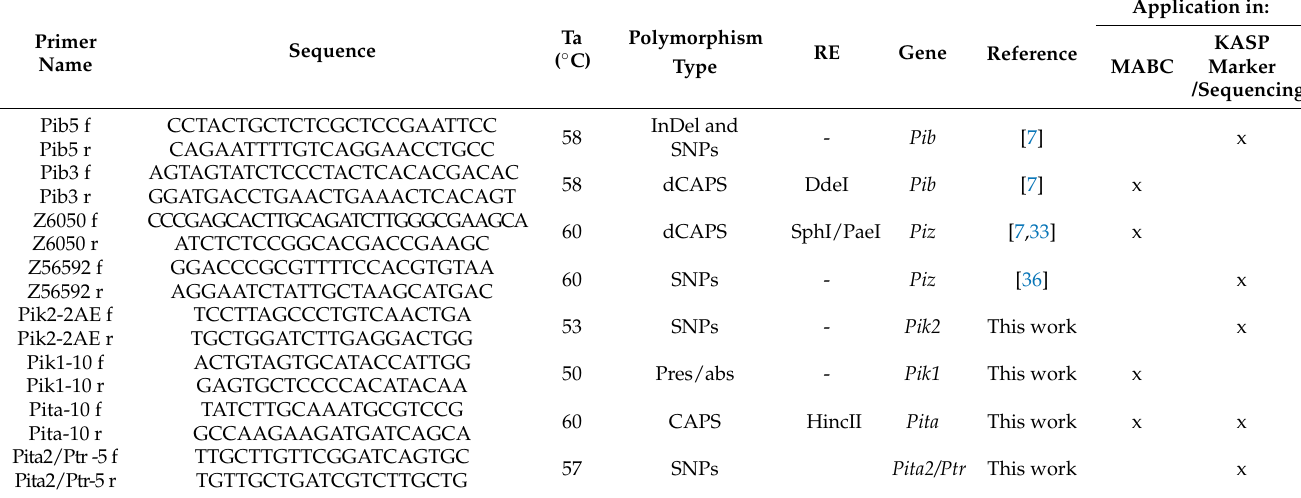
Table 1. List of the primers. For each primer, the name, sequence, annealing temperature (Ta), poly- morphism type, restriction enzyme (RE, in the case of CAPS and dCAPS markers), gene, reference, and application are reported. InDel = Insertion/Deletion; SNP = Single Nucleotide Polymorphism; CAPS = Cleaved Amplified Polymorphic Sequence; dCAPS = derived Cleaved Amplified Polymor- phic Sequence; Pres/abs = presence/absence.